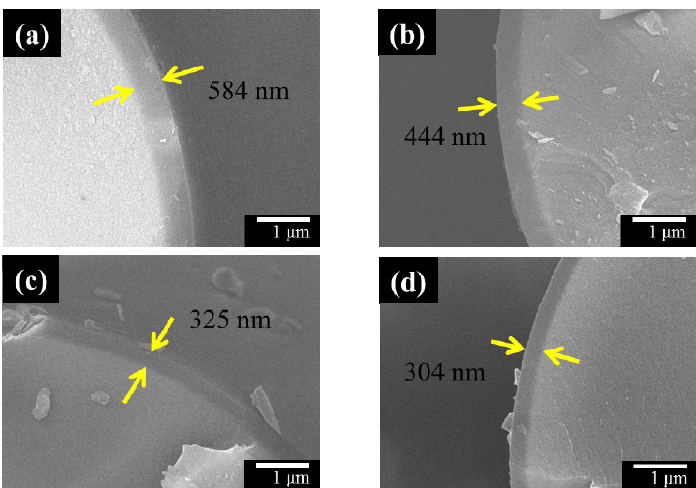
Fig. 10 Cross-section FE-SEM images of SiC fiber after oxidation resistance test at different heating rates: (a) 10 ℃ /min, (b) 20 ℃ /min, (c) 30 ℃ /min, and (d) 40 ℃ /min at 1100 ℃